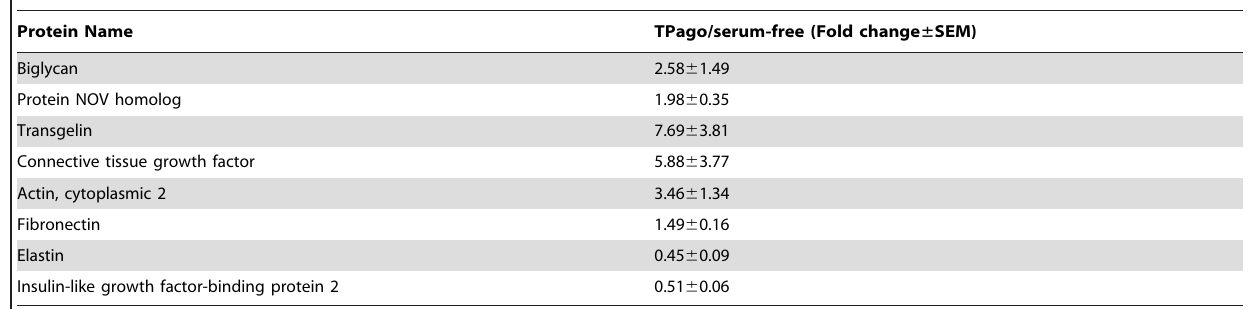
Table 1. TP-induced secreted protein from the DA smooth muscle cells.